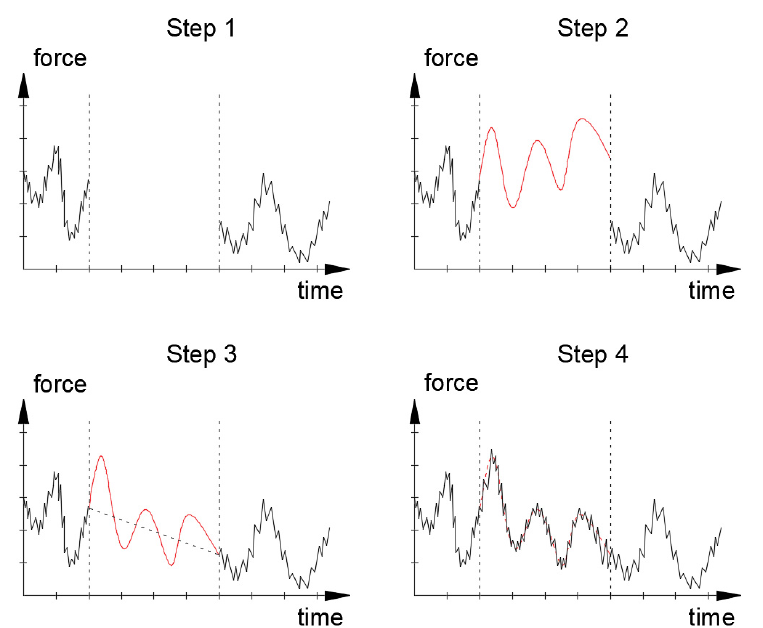
Figure 19. Data simulation scheme. Step 1: no data; step 2: simulating the average course of forces on the following days on the basis of a randomly selected Fourier series from the created database; step 3: linear data fit correction; step 4: sim- ulation of amplitudes using the inverse distribution